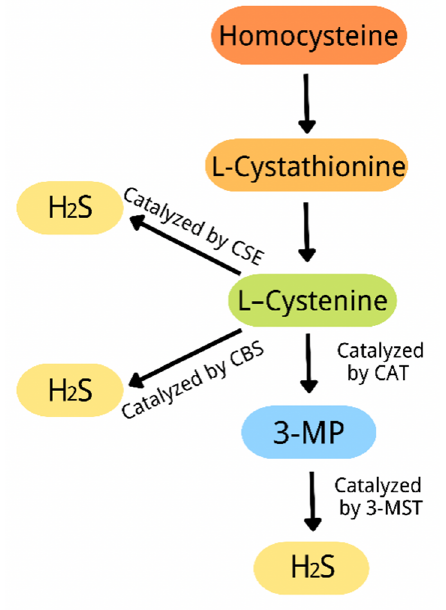
Figure 2. A schematic diagram of the endogenous H 2 S production process.